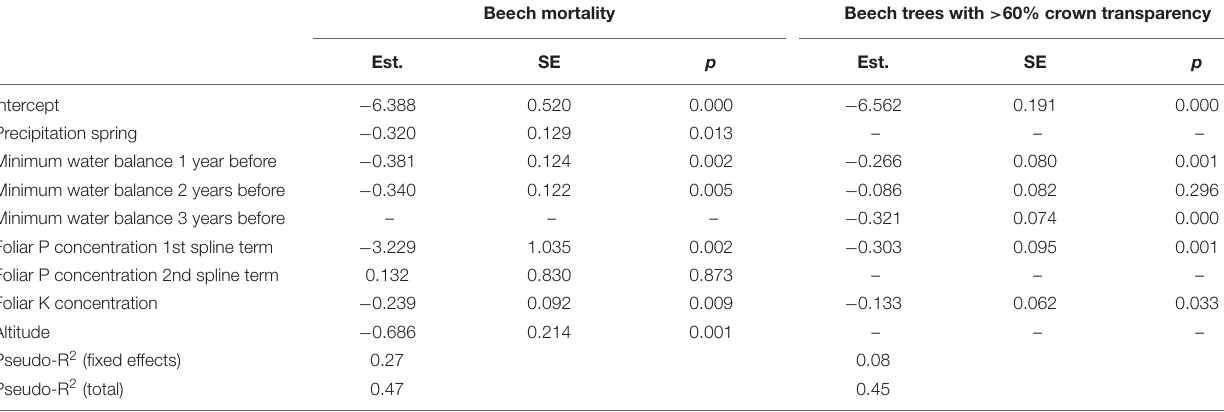
TABLE 1 | Results of mixed binomial regression models of beech mortality (left) and trees with 60% crown transparency (right). Beech mortality